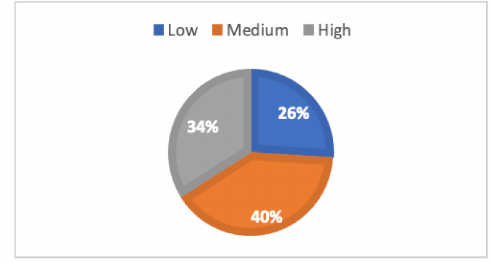
Figure 7. Perception of the degree of tourism development of las M é dulas. Source: Author’s